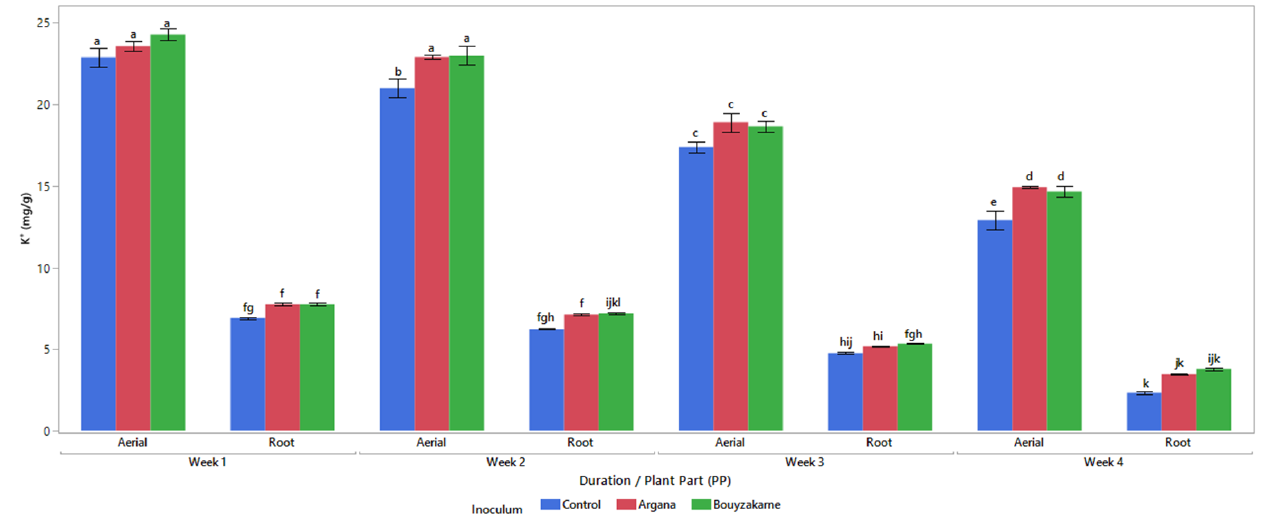
Figure 2. Fresh (FM) and dry (DM) matter of the aerial (A) and root (R) parts and the ratio of the material mass of the root part to the aerial part of mycorrhizal or non-mycorrhizal argan plants subjected to the stress of soil water deficit for a month (each error bar is constructed using 1 standard error from the mean). Values with different letters are significantly different (Tukey’s test p ≤ 0.05).